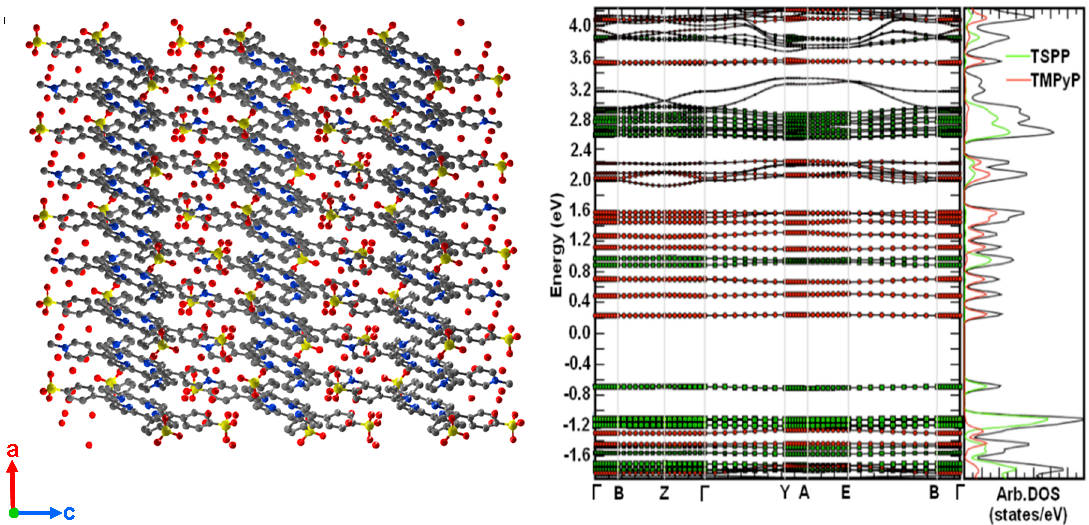
Figure 2. On the left, crystal structure of meso-tetra(N-methyl-4-pyridyl)porphyrin (TMPyP):meso-tetra(4-sulfonatophenyl)porphyrin (TSPP) nanorods in direction normal to the crystallographic b axis, showing the alternating cationic and anionic porphyrin tectons within the columns. Color codes: blue, N; gray, C; yellow, S; red, O. On the right is the projected density of states and band structure for the TMPyP:TSPP crystal computed from periodic density functional theory (PDFT). The Fermi level (E f ) is set as zero. The high symmetry points the Brillouin zone are as follows, G = (0,0,0), Z = (0,0,0.5), Y = (0,0.5,0), X = (0.5,0,0), A = ( − 0.5,0,0.5), E = ( − 0.5,0.5,0.5), B = (0,0,0.5). Reproduced from reference [42] published by The Royal Society of Chemistry.